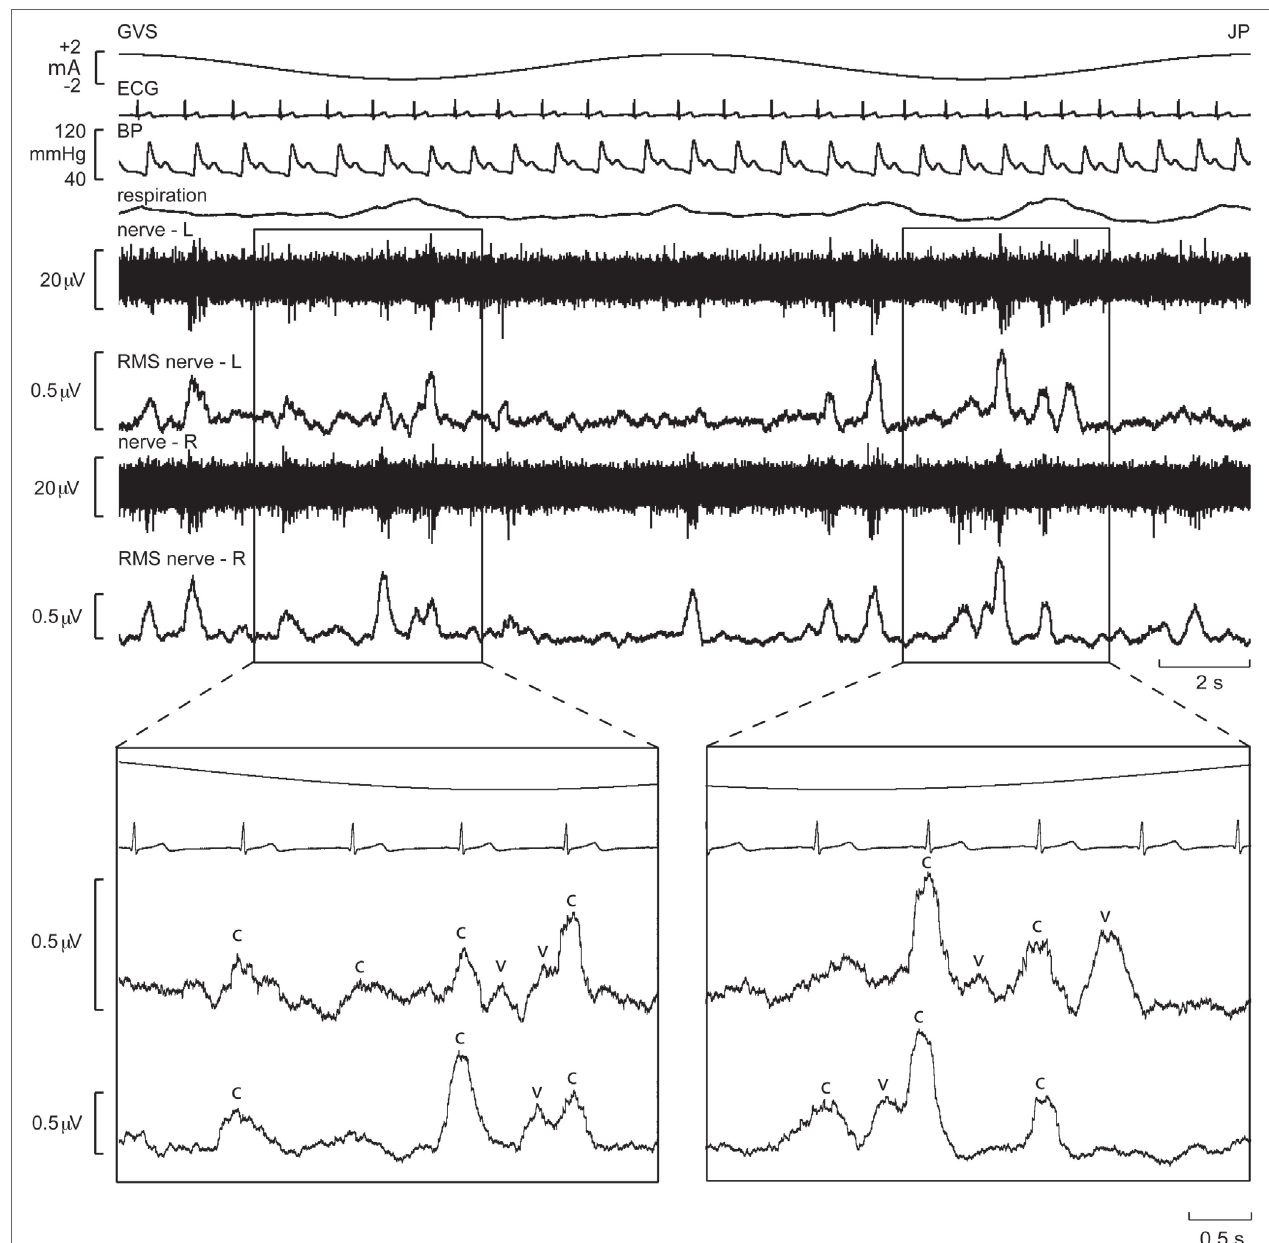
FiGURe 6 | Bilateral recordings of muscle sympathetic nerve activity, together with ECG, blood pressure, and respiration, during sinusoidal GVS (galvanic vestibular stimulation) at 0.08 Hz in one subject. Overall, sympathetic outflow was similar between the two sides, but close inspection revealed subtle differences. In the expanded sections, the sympathetic bursts have been shifted back 1.25 s in time to account for peripheral conduction delays, allowing those bursts aligned with the cardiac cycle (“c”) or vestibular stimulus (“v”) to be identified. Reproduced with permission from El Sayed et al.